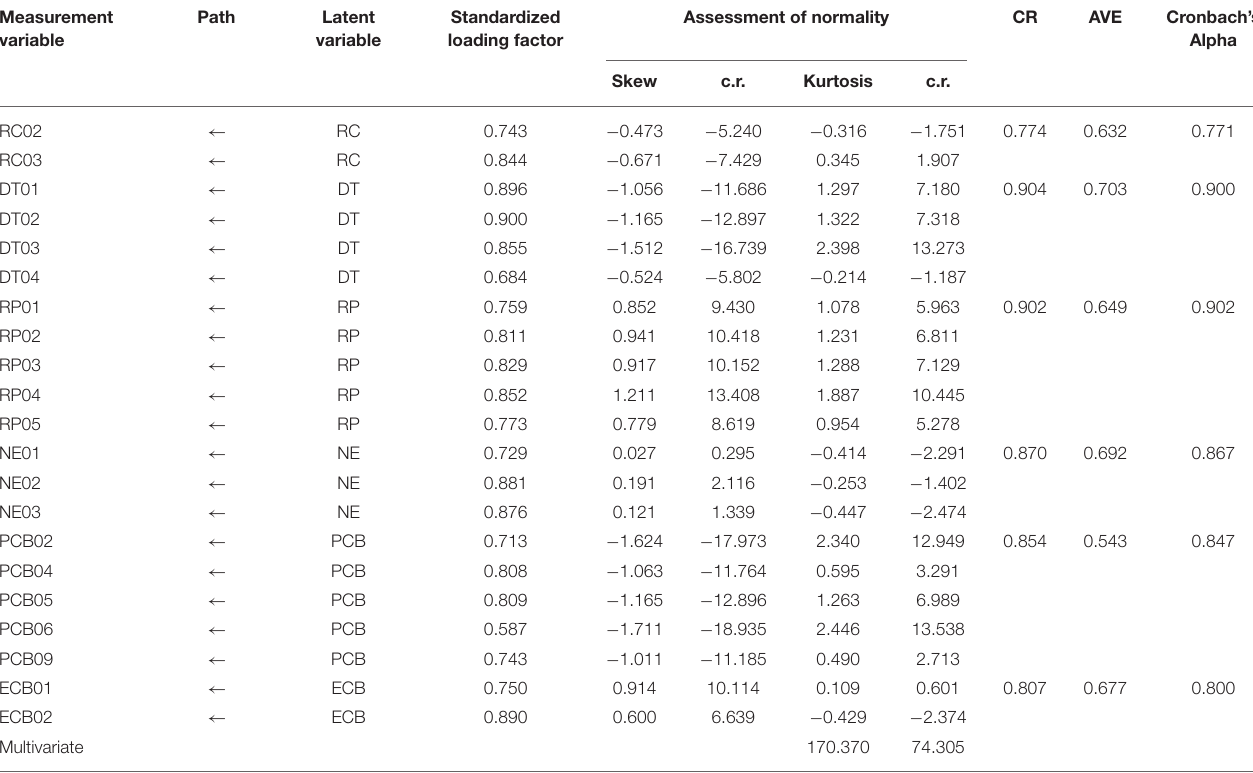
TABLE 2 | Structural validity and reliability. Measurement variable